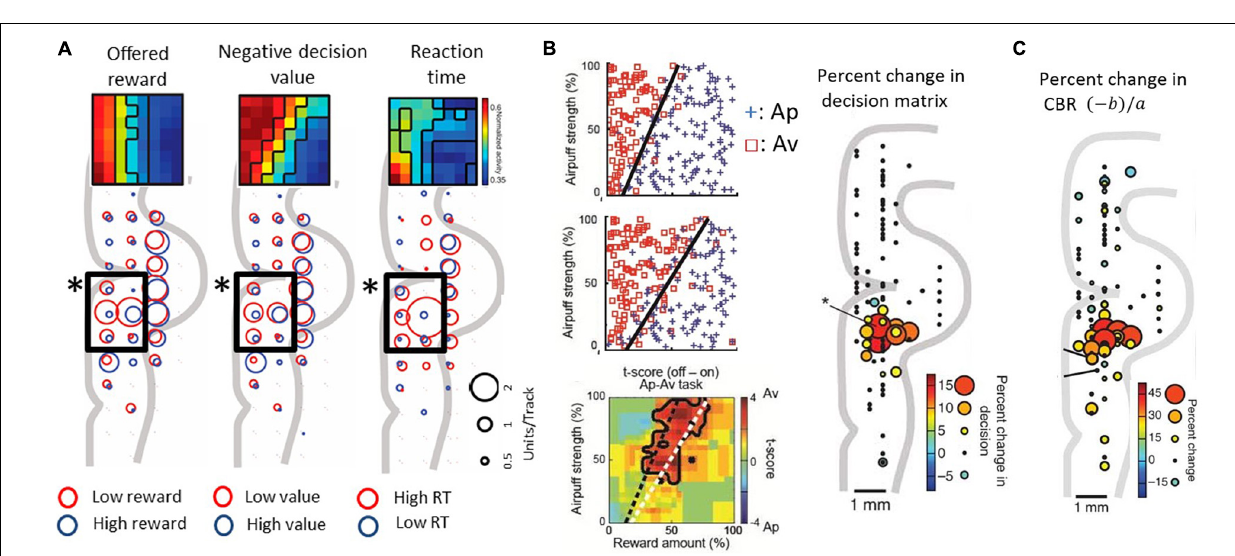
FIGURE 3 | Primate pACC is causally involved in pessimistic decision-making (modified from Amemori and Graybiel, 2012 and Amemori et al., 2018). (A) pACC neuronal response. The size of the circle indicates the number of neurons whose activity correlates positively or negatively with the parameter. In the pACC, which is shown by a square frame, neurons that were negatively correlated with presented reward (left), negatively correlated with value (middle), and positively correlated with reaction time (right) were dominant (Fisher’s exact test, P < 0.05). The population means of the activity pattern of these neurons are shown in the upper part as a matrix. The horizontal axis is the size of the reward to be presented, and the vertical axis is the air puff strength to be presented. (B) Increased avoidance choice by pACC stimulation. (Left figure) The boundary (dashed line) between Ap and Av was changed by delivering the electrical microstimulation in the pACC. Calculation of expected utility with a computational model revealed that pACC microstimulation led to the overestimation of punishment (Right figure) The sites where the small electrical stimulation had an effect on decision-making. (C) Increase in CBR due to stimulation (%). The amount of increase was indicated by the size and color of the circle at the stimulation